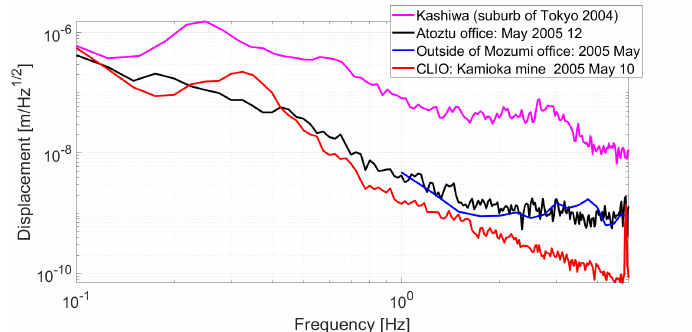
Figure 3. This figure shows the typical spectral density of the seismic noise displacement measured in an underground location at Kamioka (red curve) and compared to those measured at the surface (Tokyo areas). This plot was made using the data shown in Figure 4 in